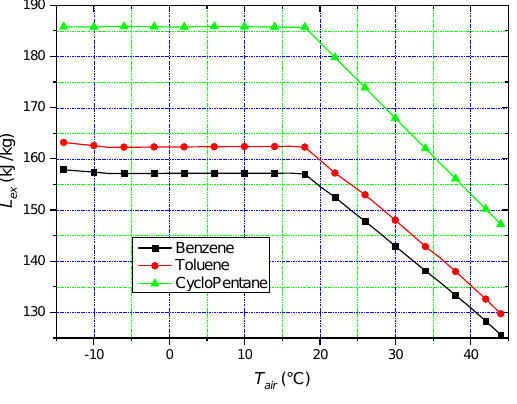
Figure 11. Expander specific work varying ambient